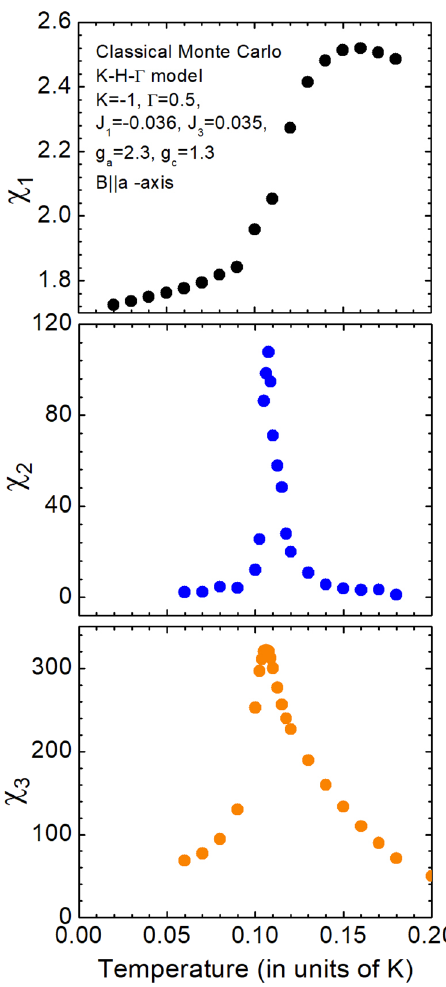
Fig. 4 CMC simulations. This fi gure shows the temperature dependence of the linear and nonlinear susceptibilities obtained in Monte Carlo calculations, for B ∥ a -axis. χ 2 (middle panel) rises rapidly to positive values at T C reaches a maximum and drops sharply again below T C . This latter feature is in sharp contrast to the experimental results where the large positive χ 2 persists to the lowest temperatures measured. Similar results in contrast to the experiment are obtained for the behavior of χ 3 . It also attains a positive value below T ≈ 0.11 (in units of K 1 ), reaches a peak value near T N , and rapidly decreases at lower temperatures (lower panel). Note that y -axis scale is